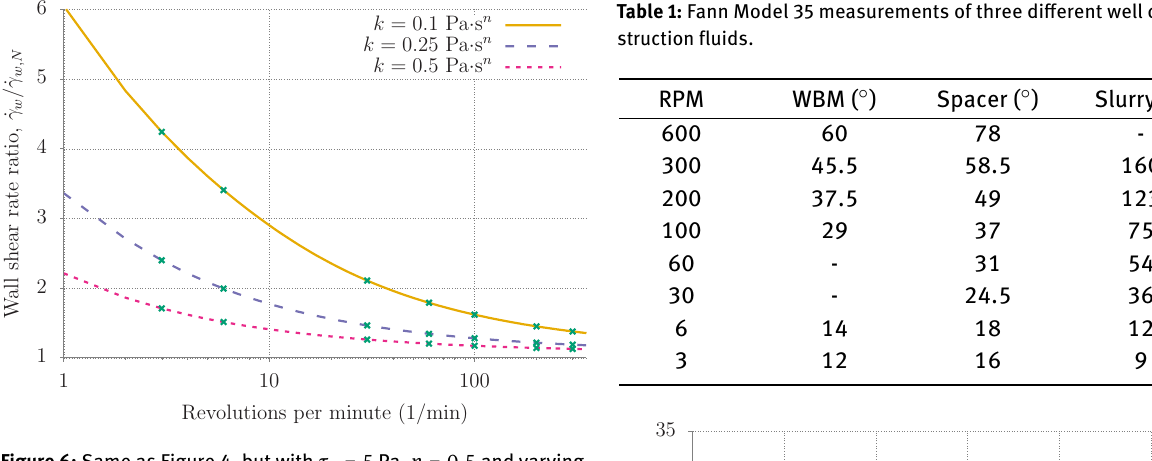
Figure 6: Same as Figure 4, but with τ y = 5 Pa, n = 0.5 and varying k .